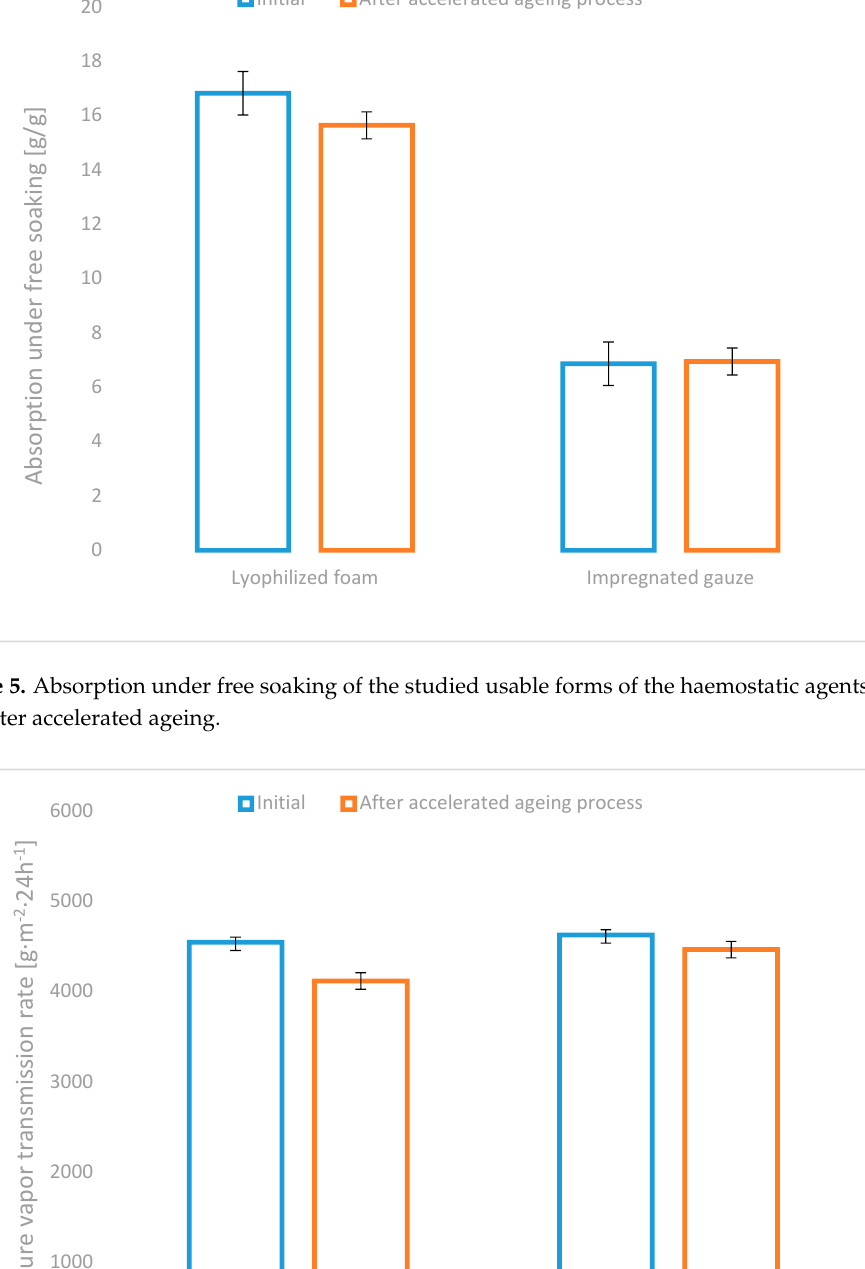
Figure 6. MVTR of the studied usable forms of the haemostatic agents before and after accelerated ageing.